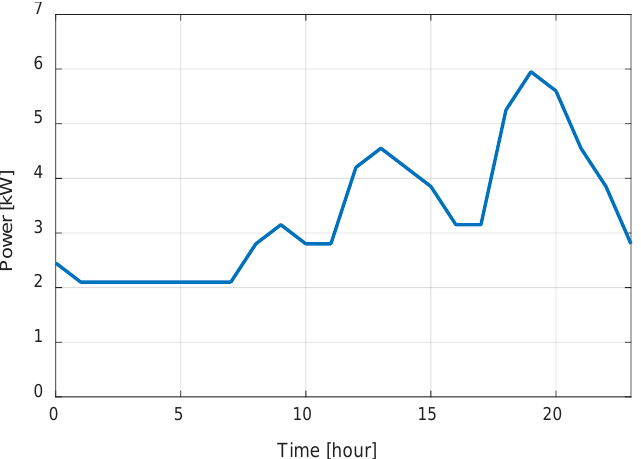
Figure 2. Electricity load demand for the entire residential complex, consisting of seven apartments. The illustrated trajectory was initially extracted from 24 and then adapted to suitably represent the average daily profile of dwelling electricity demand [24].